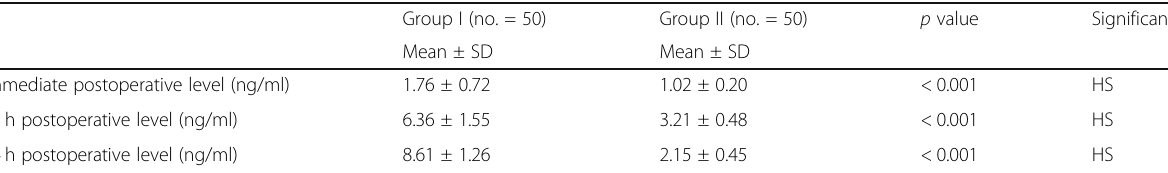
Table 3 Postoperative troponin I level (ng/ml)